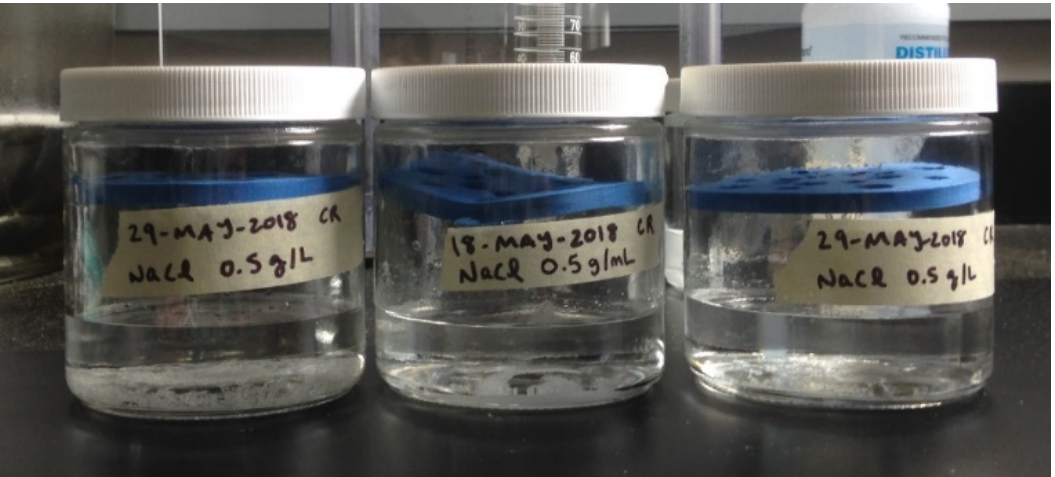
Figure 1. Each experimental chamber was prepared with 100 mL of saturated salt solution, a (blue) support (on which the sample was placed) and closed tightly with vacuum grease. A capillary tube of thymol was also placed in each jar to inhibit microbial growth.